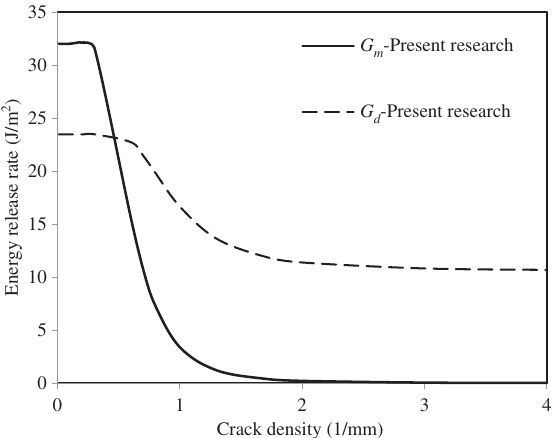
] s carbon/ 3 = 10 2